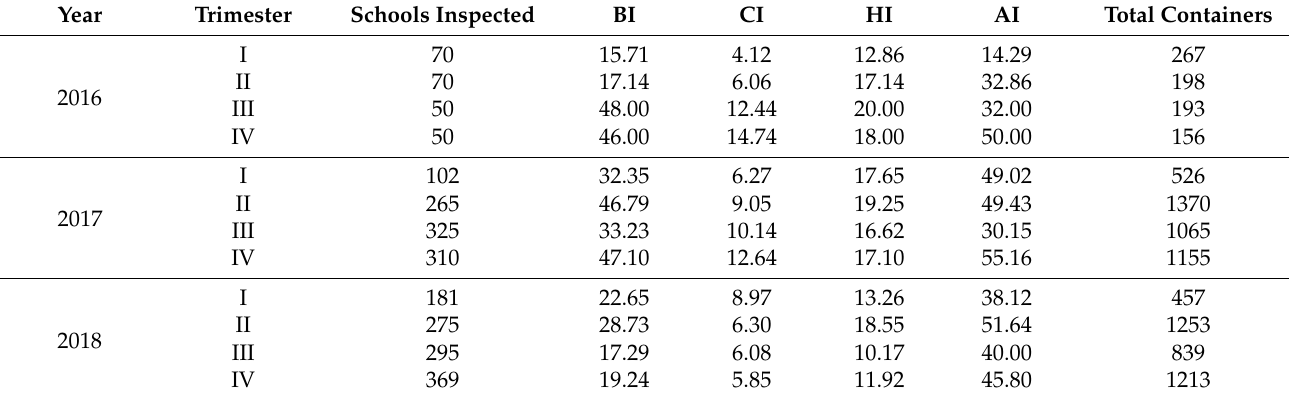
Table 3. Traditional Aedes indices estimated for schools inspected between 2016 and 2018 in Medell í n, Colombia.